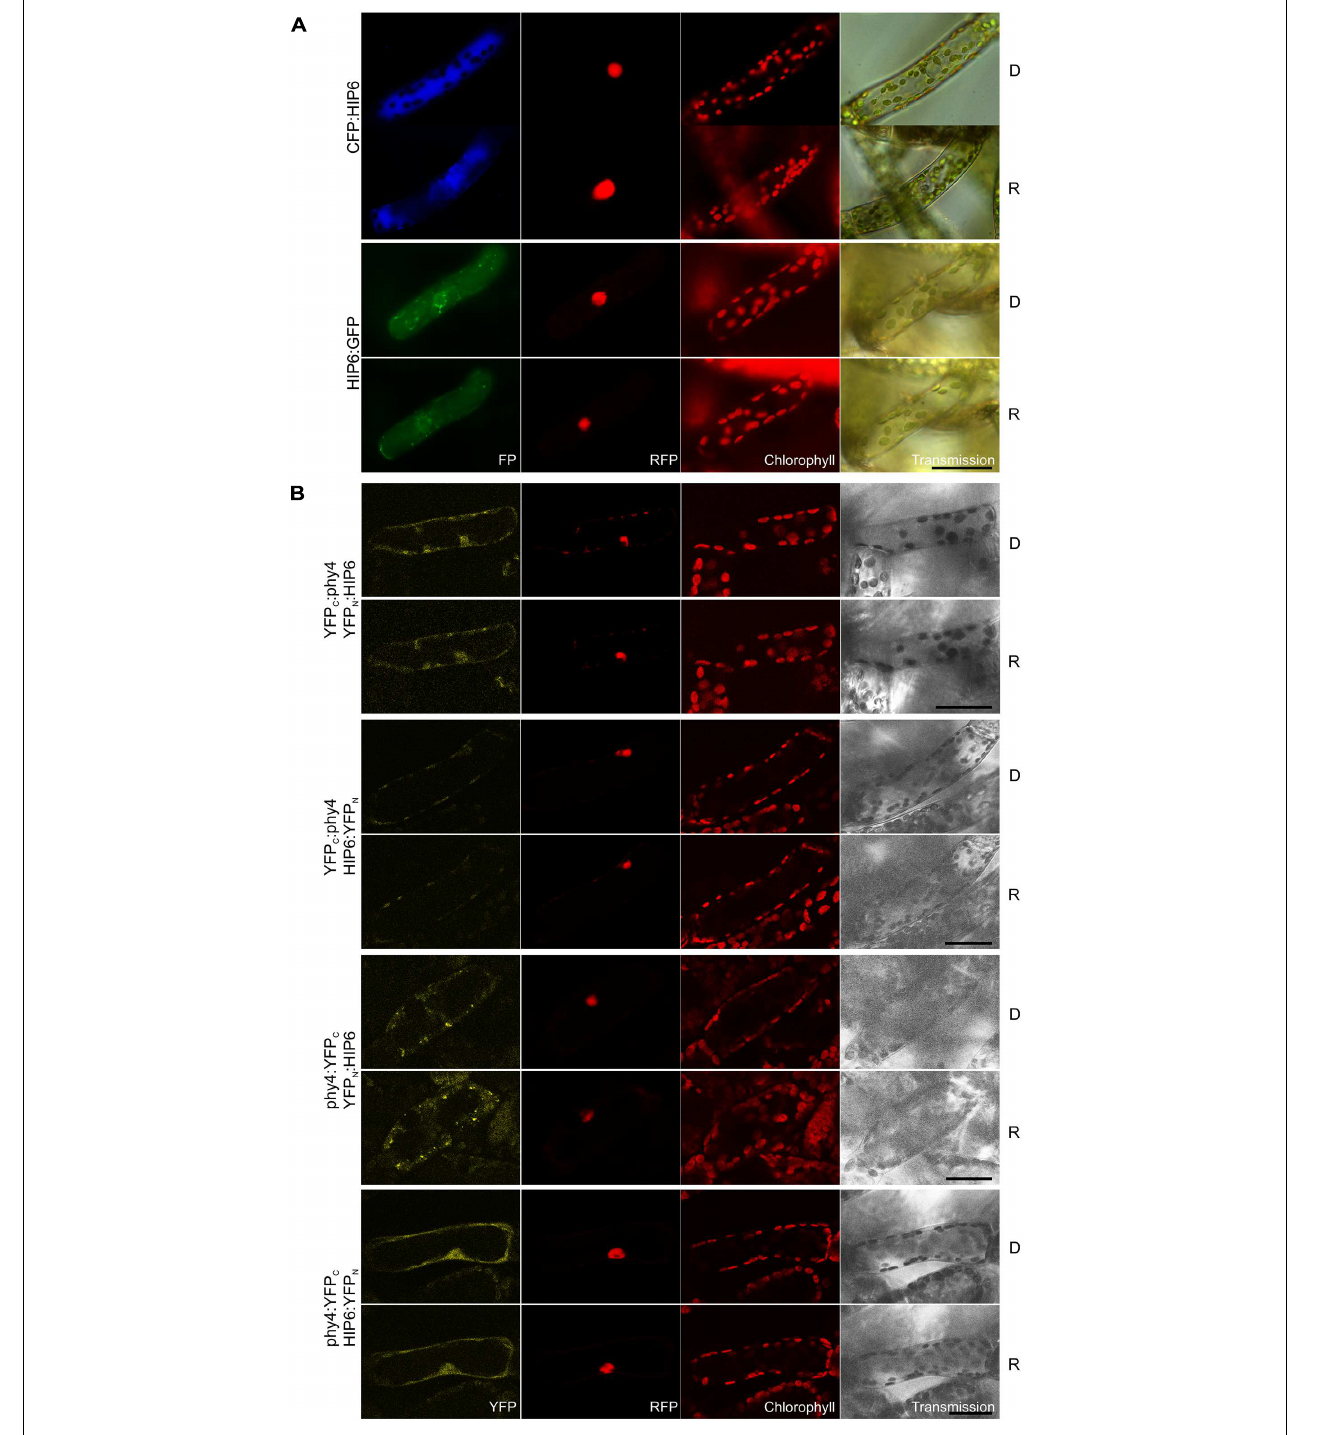
FIGURE 5 | HIP6 (Pp3c6_4480V1.1) intracellular localization (A) and split-YFP-studies of HIP6–phy4 interaction (B) each without (D) and with red pre-treatment (R) using fluorescence- and confocal microscopy, respectively. Overall figure structure is analogous to Figure 1 . (A) Intracellular localizations of CFP:HIP6 (rows 1 and 2) and HIP6:GFP (rows 3 and 4) were both localized in the cytoplasm, with HIP6:GFP showing subcellular foci (column 1, FP). (B) All four split-YFP configurations were investigated: YFP C :phy4–YFP N :HIP6 (rows 1 and 2), YFP C :phy4–HIP6:YFP N (rows 3 and 4), phy4:YFP C –YFP N :HIP6 (rows 5 and 6), and phy4:YFP C –HIP6:YFP N (rows 7 and 8). Significant YFP signals were apparent only for phy4:YFP C –YFP N :HIP6 (cytoplasm and cytoplasmic foci) and phy4:YFP C –HIP6:YFP N (cytoplasm and nucleus; column 1, YFP), whereas apparent YFP C :phy4–YFP N :HIP6 nuclear fluorescence might represent RFP bleed-through and YFP C :phy4–HIP6:YFP N only shows chloroplast bleed-through. Scale bars 30 µ m.